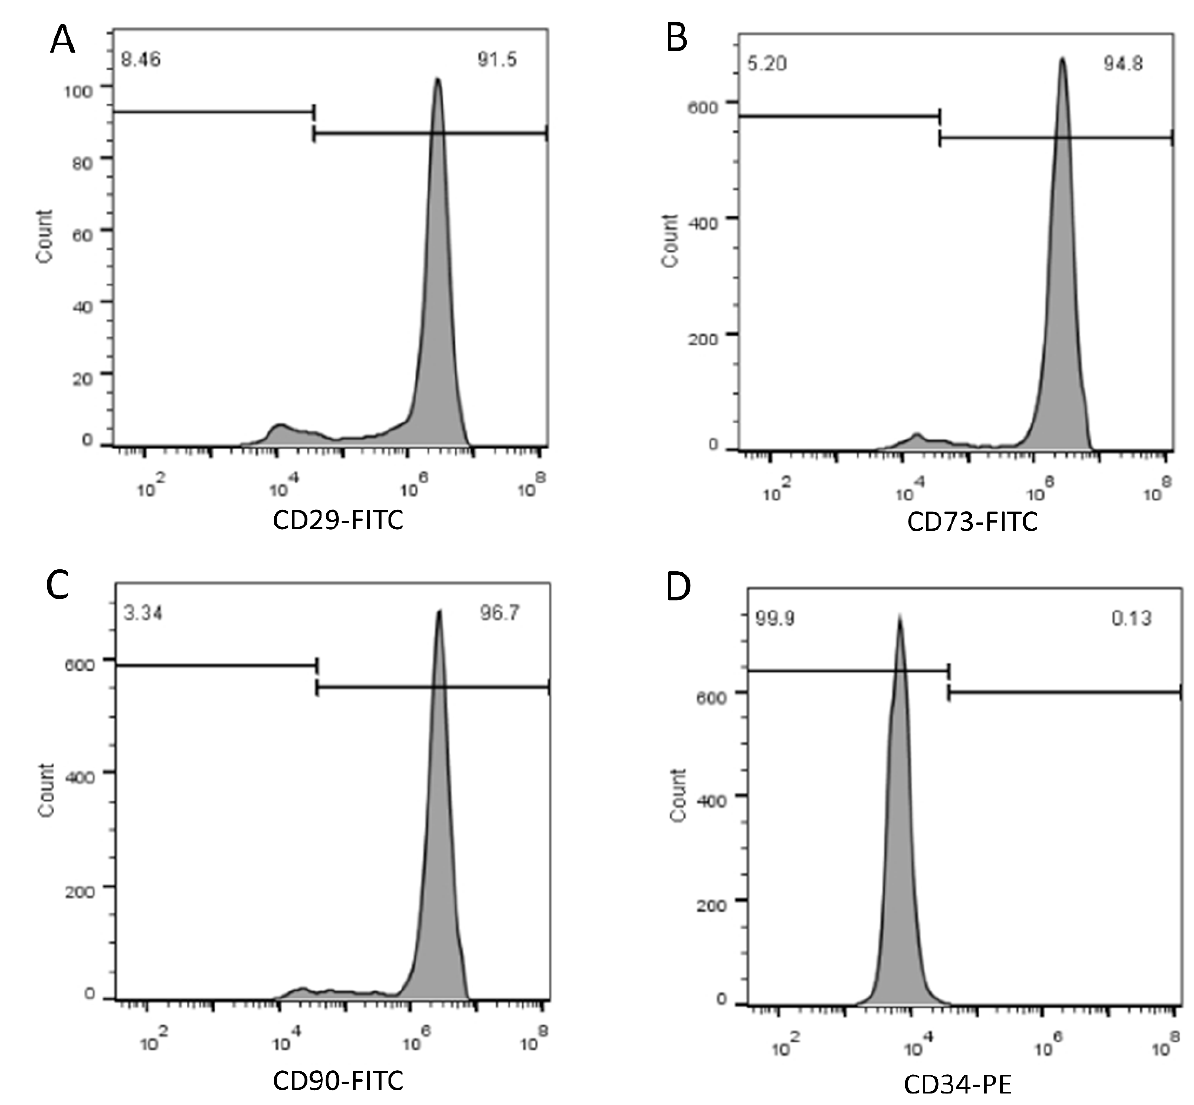
Fig. 2. Flow cytometry detection of passage 3 dental pulp stem cells. Cells expressed mesenchymal surface markers CD29 (91.5%, A), CD73 (94.8%, B), and CD90 (96.7%, C), while hardly expressing the hematopoietic stem cell surface marker CD34 (0.13%, D).